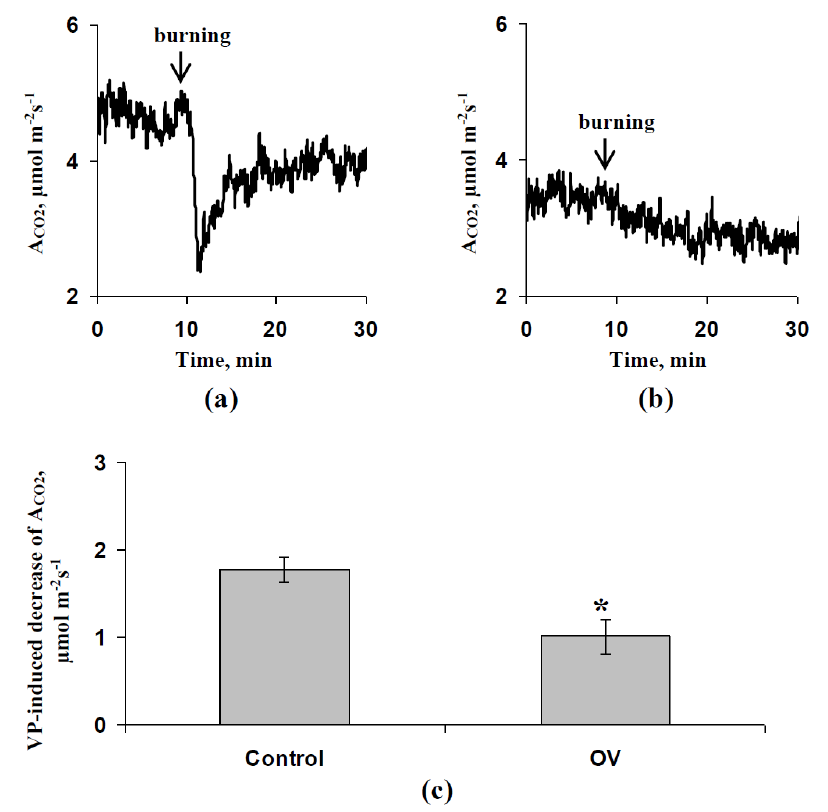
Figure 10. Influence of the modification of H + -ATP-ase activity by sodium orthovanadate (OV) on the local burning-induced decreases in CO 2 assimilation. ( a ) Local burning-induced changes in A CO2 in the leaf of a control seedling. ( b ) Local burning-induced changes in A CO2 in the leaf of a seedling after vanadate treatment. ( c ) Average magnitudes of local burning-induced A CO2 decreases ( n = 5–6). The preliminary OV treatment of the leaves of seedlings was performed by incubation of the leaf (2 h) in a solution of OV with a moderate concentration (0.5 mM); after that, this leaf was dried by filter paper and photosynthetic measurements were performed. Similar treatment by water was used in the control. Photosynthetic measurements were performed in the second mature leaf; illumination by blue actinic light (239 µmol m −2 s −1 ) was used. Local burning of the first mature leaf by a flame (3–4 s, about 1 cm 2 ) was performed 1.5 h after plant fixation for measurement. *, difference between experiment and control plants is significant ( p < 0.05).